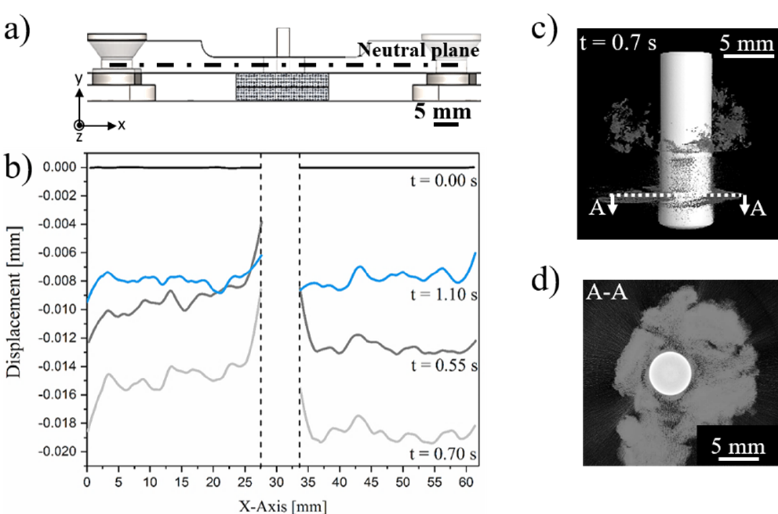
Figure 9. ( a ) Schematics showing the neutral line of the upper clamping element. ( b ) Displacement distribution through the neutral line of the upper clamping element at different joining times. ( c ) X-ray micro-computed tomography showing the side view of the friction-riveted joint at the joining time of t = 0.7 s (A-A is the plane between the composite parts). ( d ) Upper view of the A-A plane that displays the composite squeezing flow between the composite parts (Joining parameters—RS: 15,000 rpm, FF: 15 kN, DF: 7.5 mm, CP: 0.2 MPa).